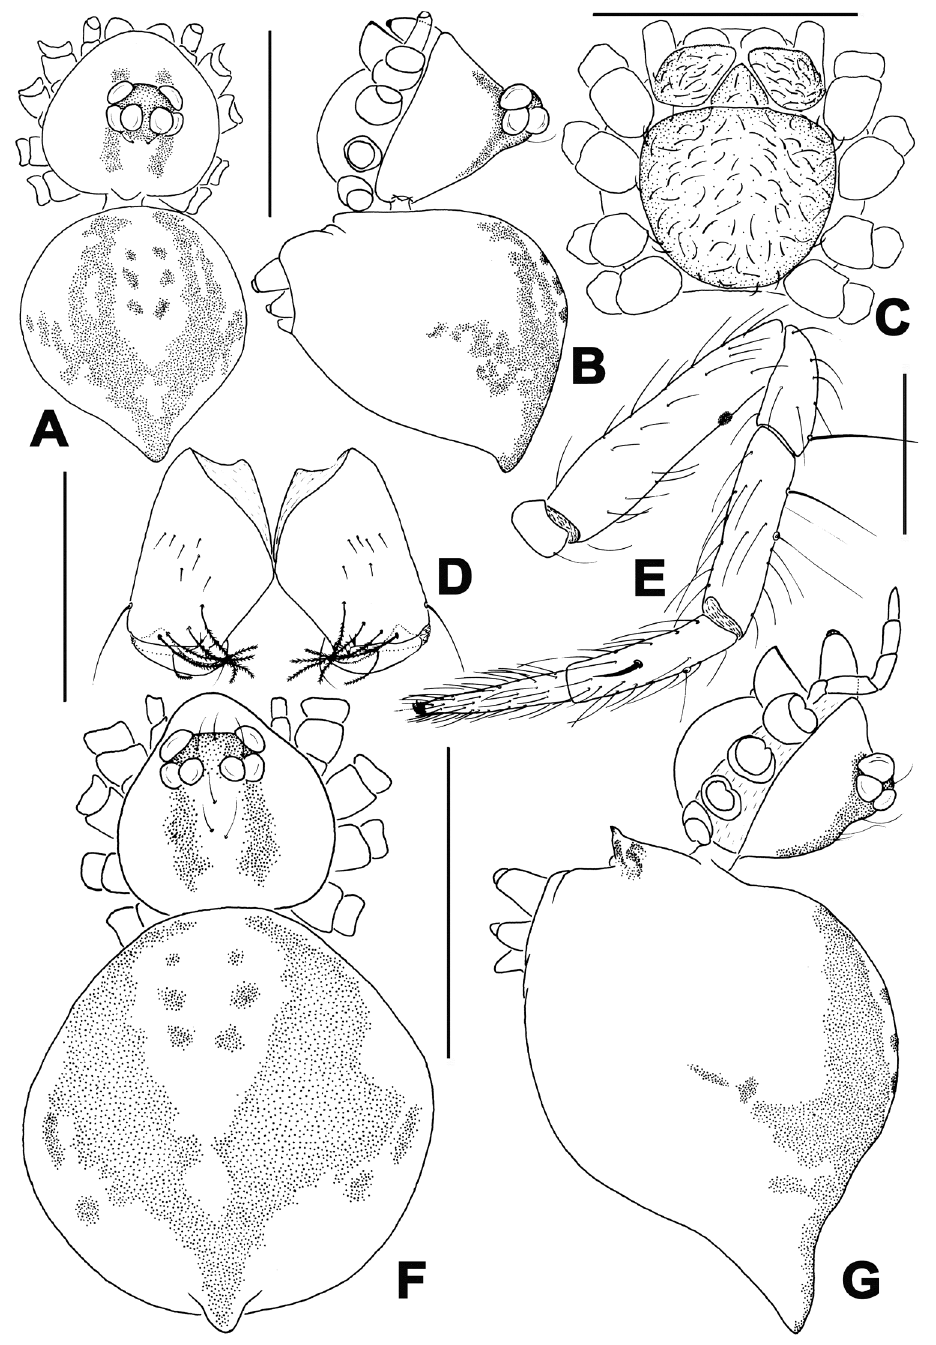
Figure 2. Trogloneta speciosum Lin & Li, 2008, male ( A–E ) and female ( F–G ). A, B Habitus C Prosoma (appendages omitted) D Chelicerae E Leg I F, G Habitus. A, F dorsal B, G lateral C ventral D posterior E prolateral. Scale bars: 0.50 mm ( A–D, F, G ) ; 0.20 mm ( E )